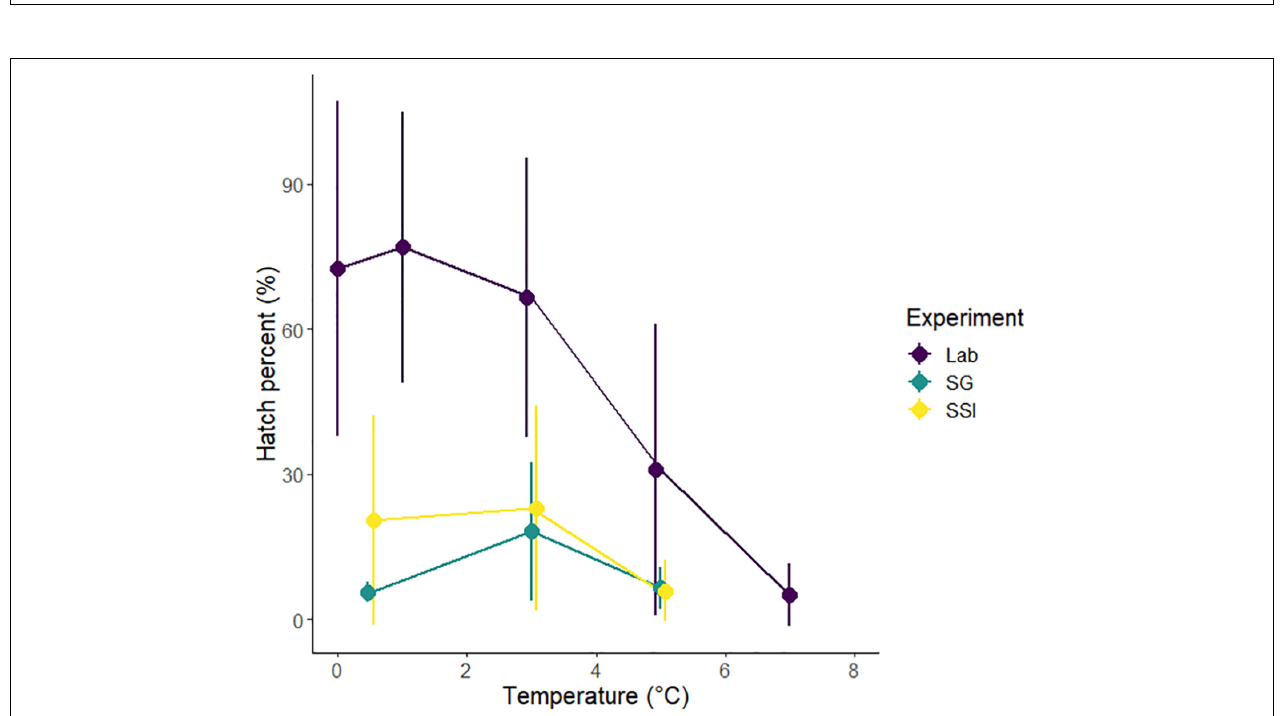
FIGURE 3 | Variation in hatching success with temperature in field and laboratory experiments. Field experiments are divided into South Georgia and the South Sandwich Islands. Mean hatching success values presented here highlight the variation between the two experiments. Each data point has been slightly offset to ensure the bar showing standard deviation is